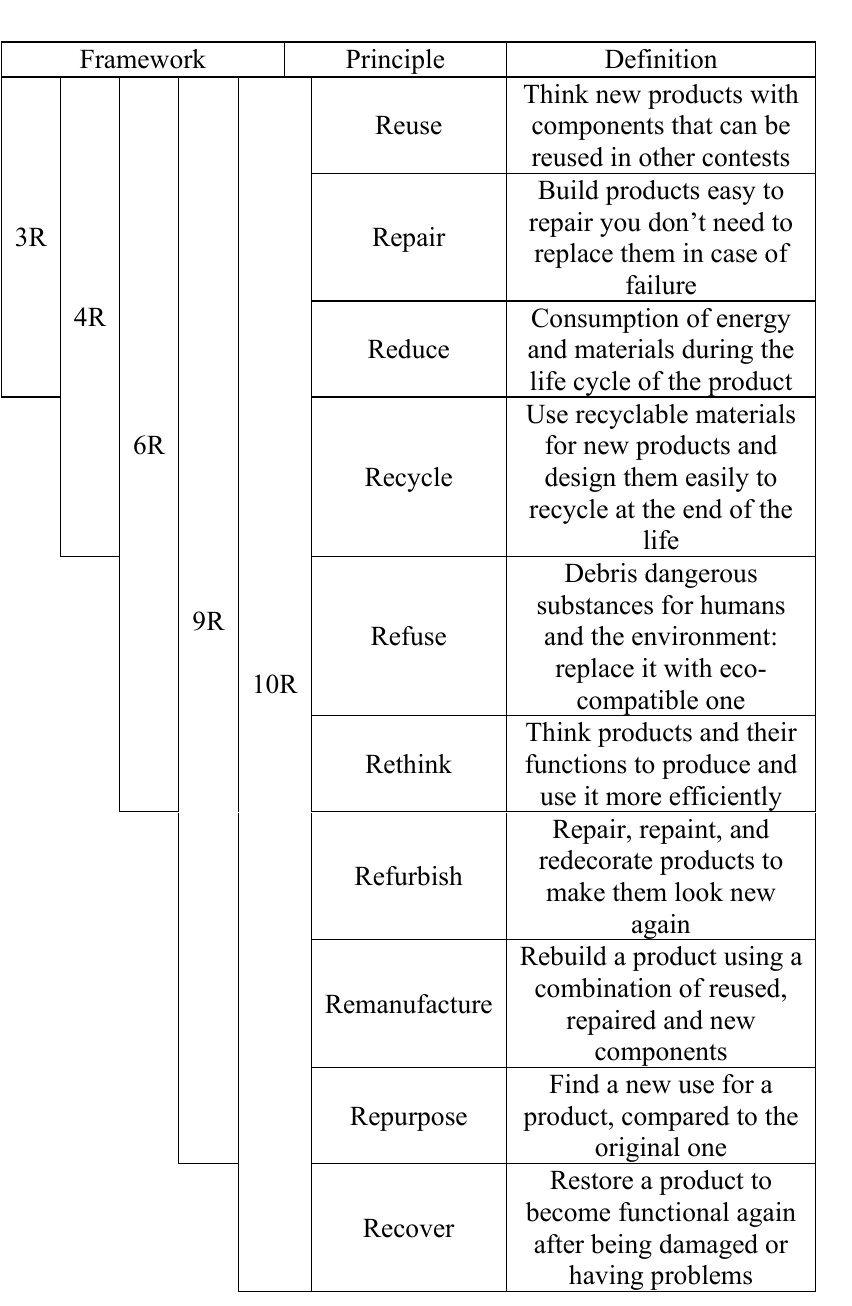
Table 1 : The “R” Framework of Circular